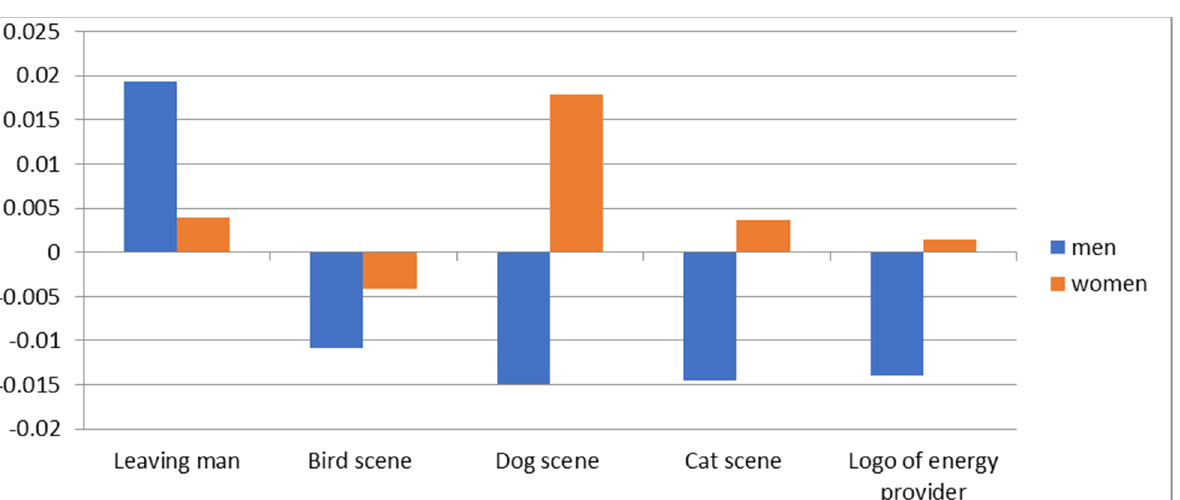
Figure 8. Average values and standard deviations of the normalized index of engagement for the Energa media message. Energa media message.